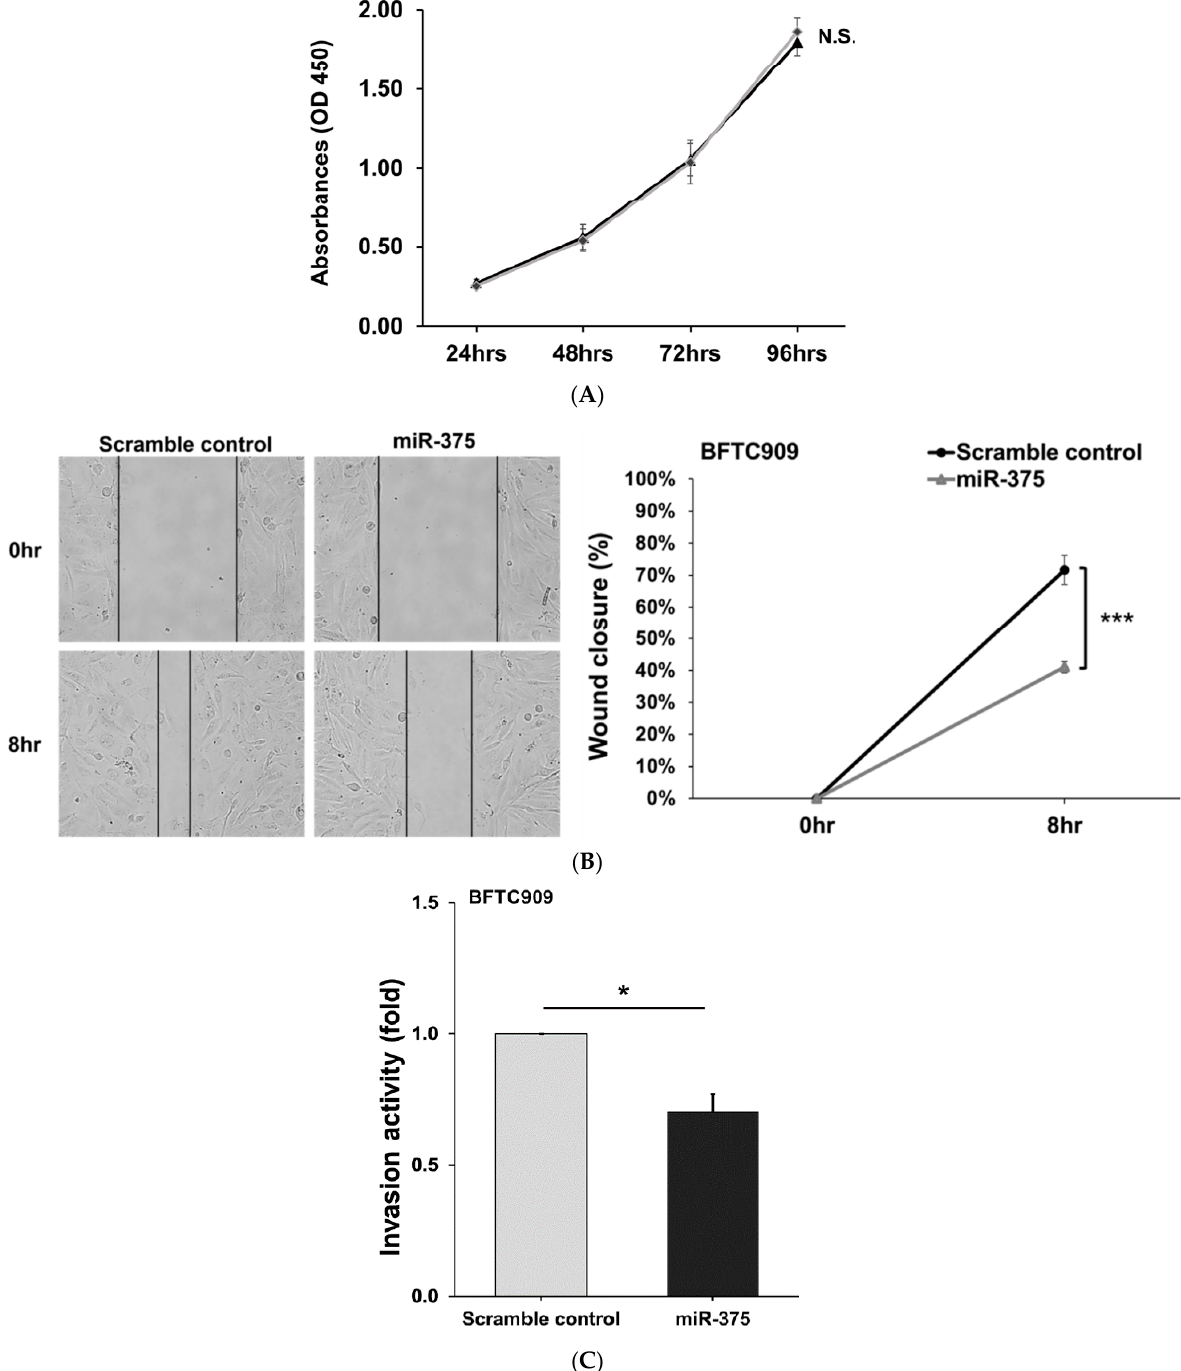
Figure 4. MiR-375 inhibits cell migration and invasion in the BFTC909 cell line. ( A )